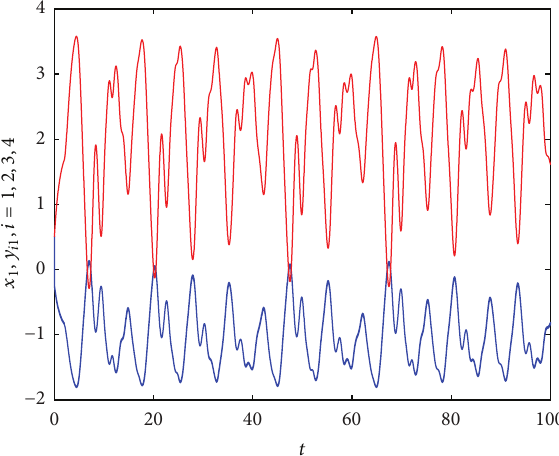
Figure 3: The trajectories of state variables with 𝜆 = −0.5